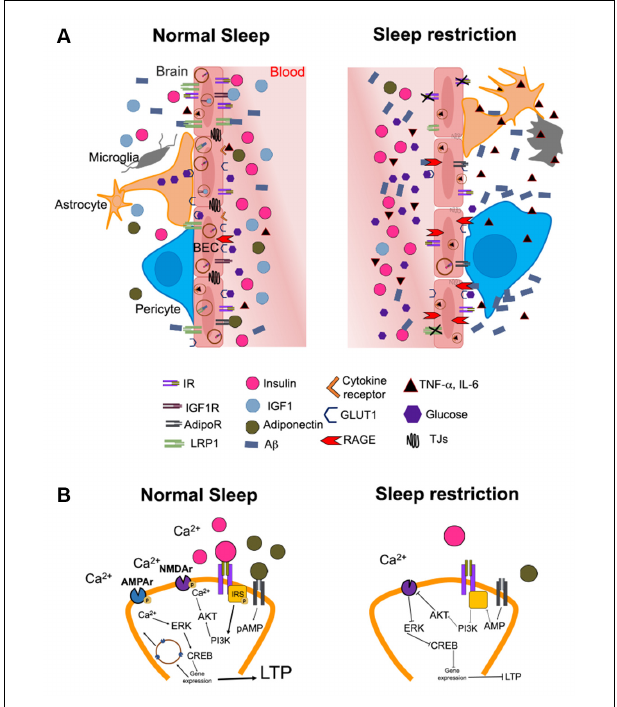
FIGURE 1 | Hypothetical mechanisms by which altered brain insulin signaling induced by sleep restriction may promote the development of Alzheimer’s disease. (A) The illustration shows the possible changes in the access of metabolic signals into the brain (e.g., hippocampus) during normal sleep and sleep restriction. Substances in the periphery are limited in their passage to the brain due to the blood-brain barrier (BBB). The BBB is constituted by brain endothelial cells, pericytes, astrocytes, microglia, and neurons. In normal sleeping conditions (left), metabolic signals such as IGF-1 (blue circles), adiponectin (green circles), glucose (purple hexagons), and insulin (pink circles) circulate in the appropriate concentrations through blood vessels and may bind to their receptors in the brain. The functions of insulin signaling include the modulation of low-density lipoprotein receptor-related protein 1 (LRP1) expression, which mediates amyloid beta (A β , blue rectangles) efflux into the bloodstream. IGF-1 and adiponectin bind to